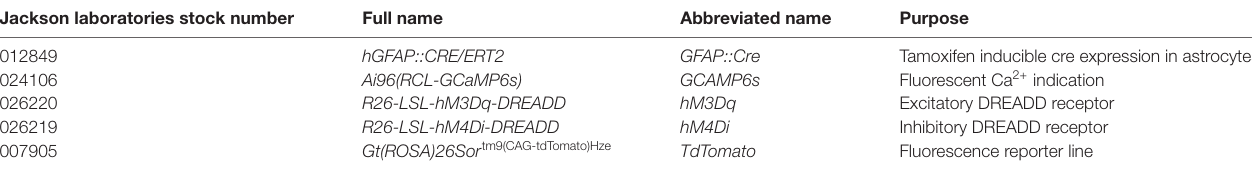
TABLE 1 | Details of the transgenic mouse lines used for the